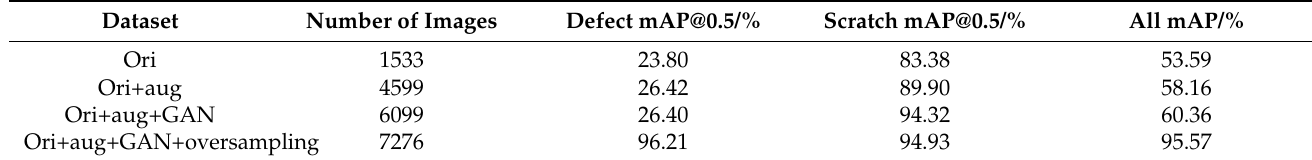
Table 3. Detection results with different